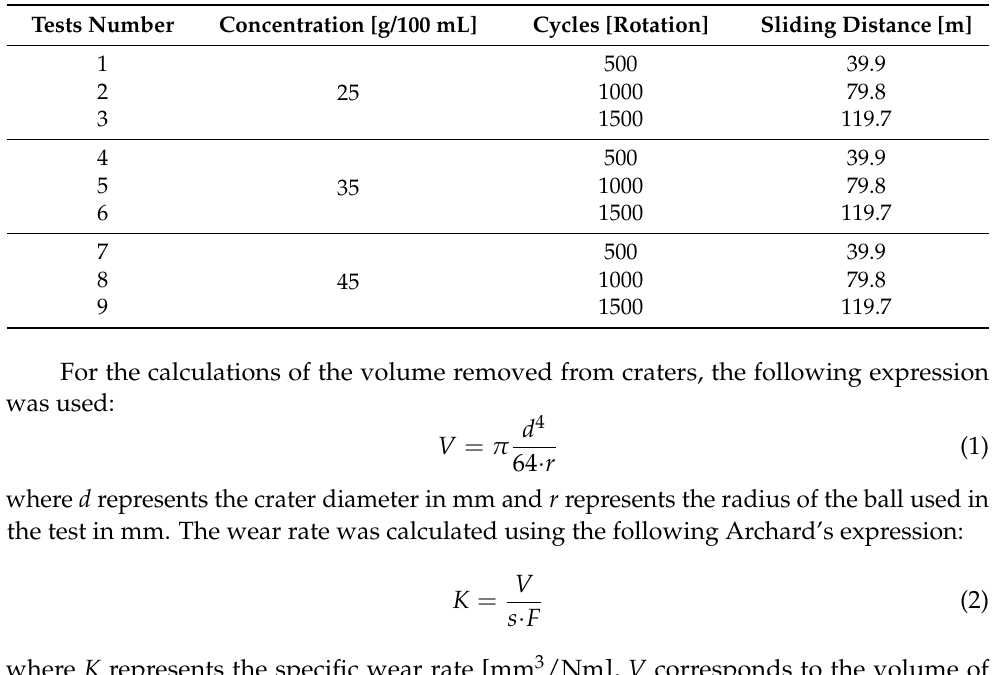
Table 3. AISI 52100 steel balls used in these tests were etched by 4% Nital for 60 s. Table 3. Microabrasion Tests (three craters per